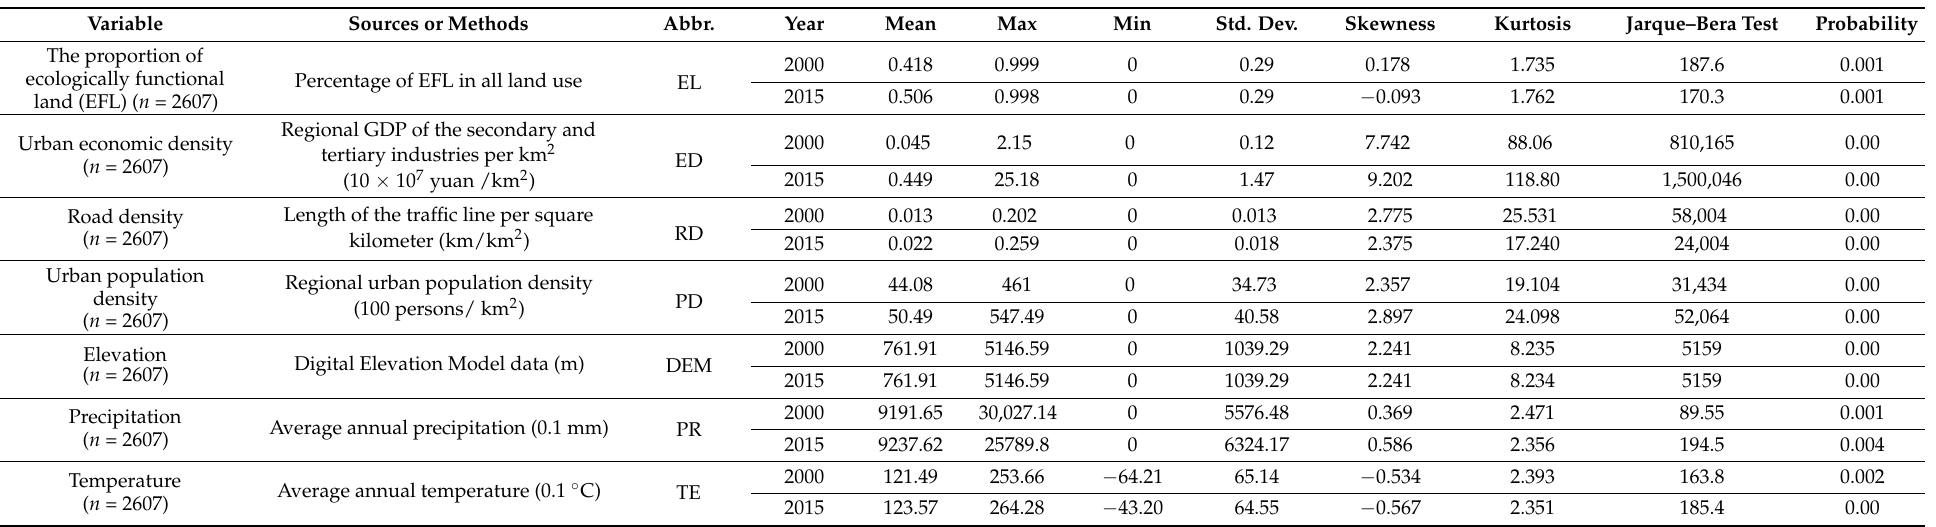
Table 1. Descriptive statistics of all the